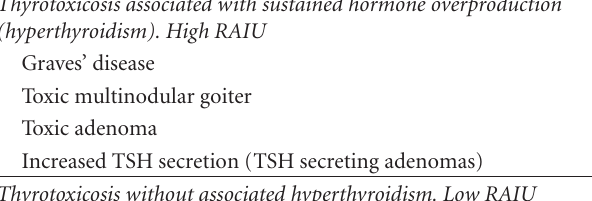
Table 5: Di ff erential diagnosis of thyrotoxicosis in children. Thyrotoxicosis associated with sustained hormone overproduction (hyperthyroidism). High